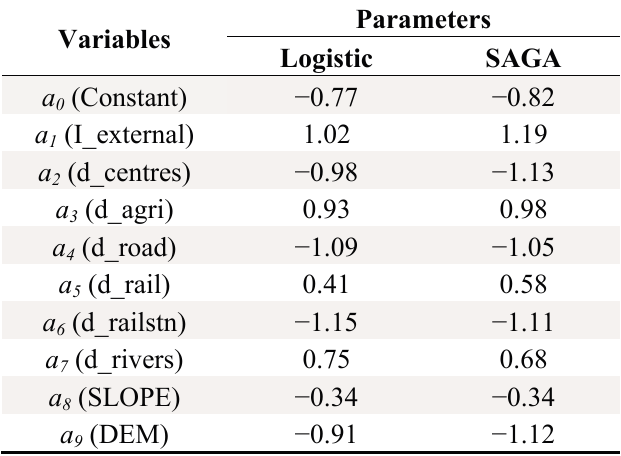
Table 2. Optimized CA parameters by the SAGA in comparison with parameters generated by the logistic regression